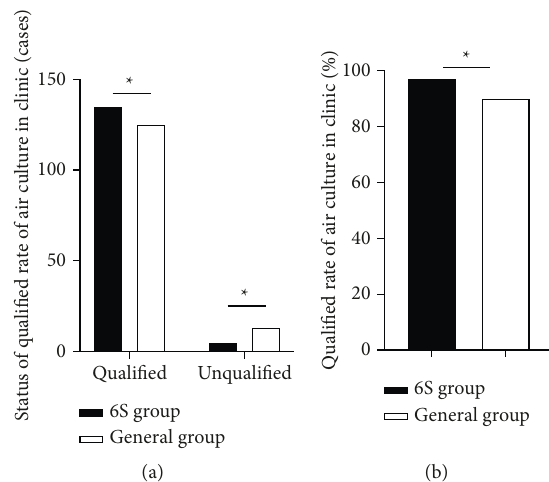
Figure 1: Analysis of air culture compliance in two groups of the consultation rooms+operating rooms. (a) Status of the qualified rate of air culture in clinic (cases). (b) The qualified rate of air culture in clinic (%). The 6S group compared to the general group, ∗ P > 0 . 05.